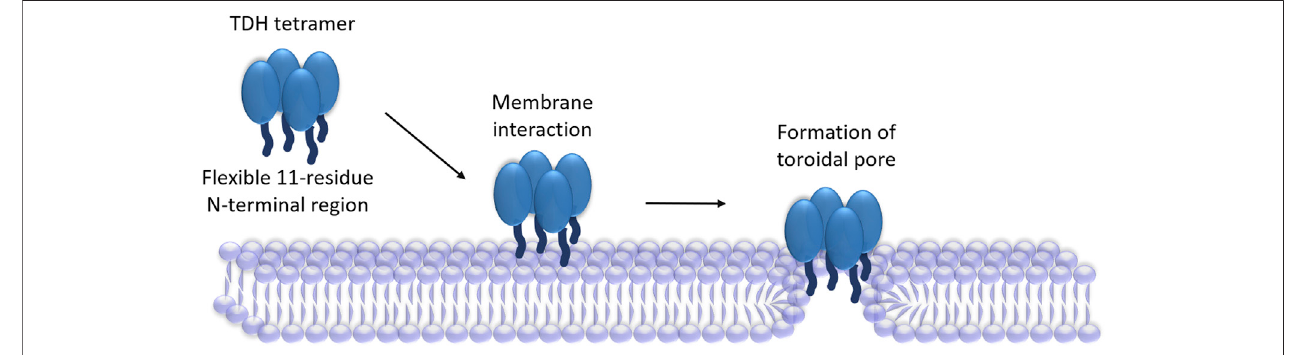
FIGURE 2 | Proposed mechanism of pore-formation by TDH. TDH tetramer interacts with the target membranes. N-terminal regions (shown as dark blue extensions) of the TDH protomers play critical roles in the pore-formation mechanism. TDH may form toroidal pores, in which pore-lining could be created with the collaboration of the N-terminal regions of the protein and membrane